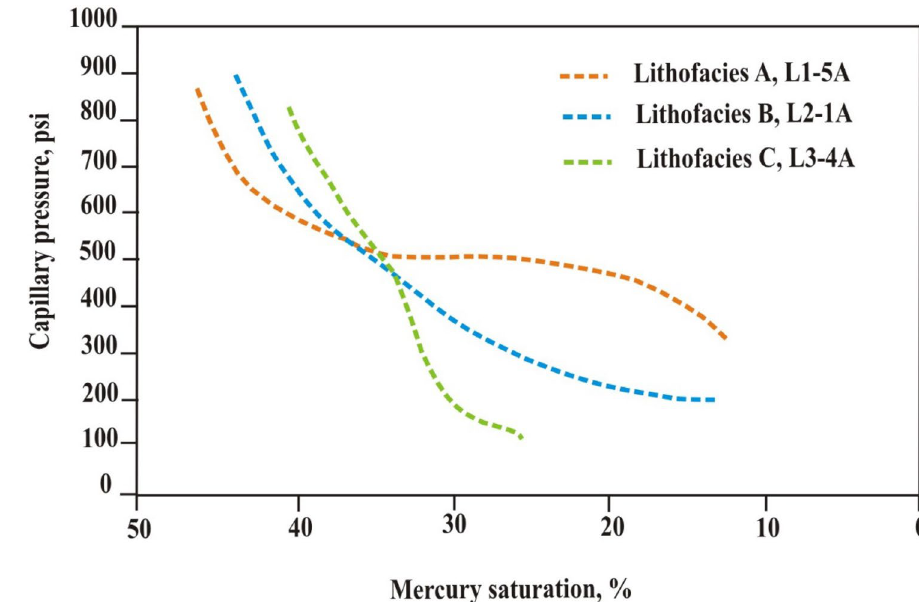
Fig. 14 Mercury-capillary curves of sandstones of Hay- mana